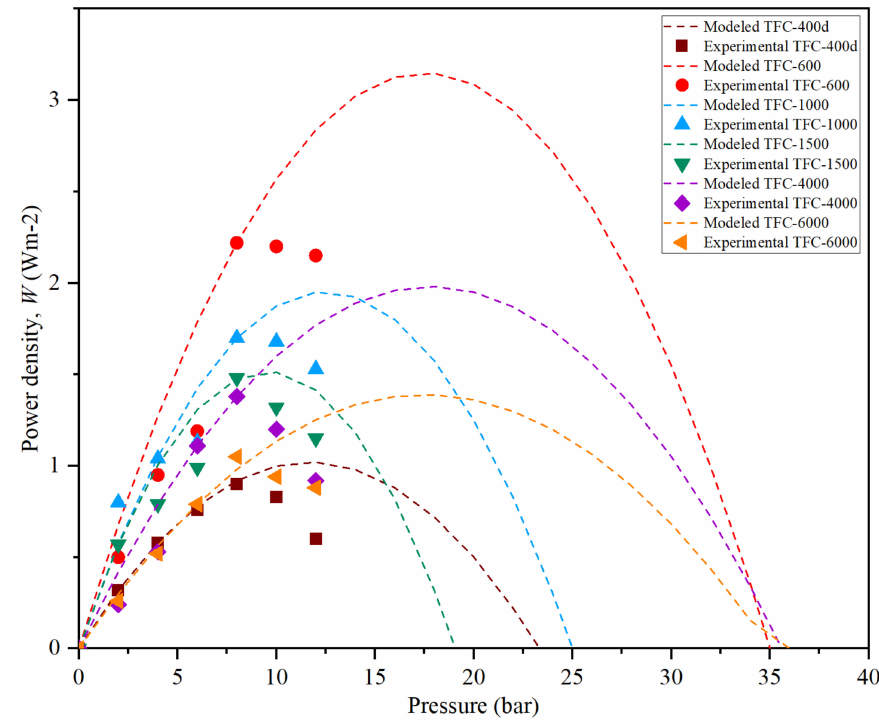
Figure 12. The modeled and experimental results on the power-density profiles for modified TFC membranes with different M w s of